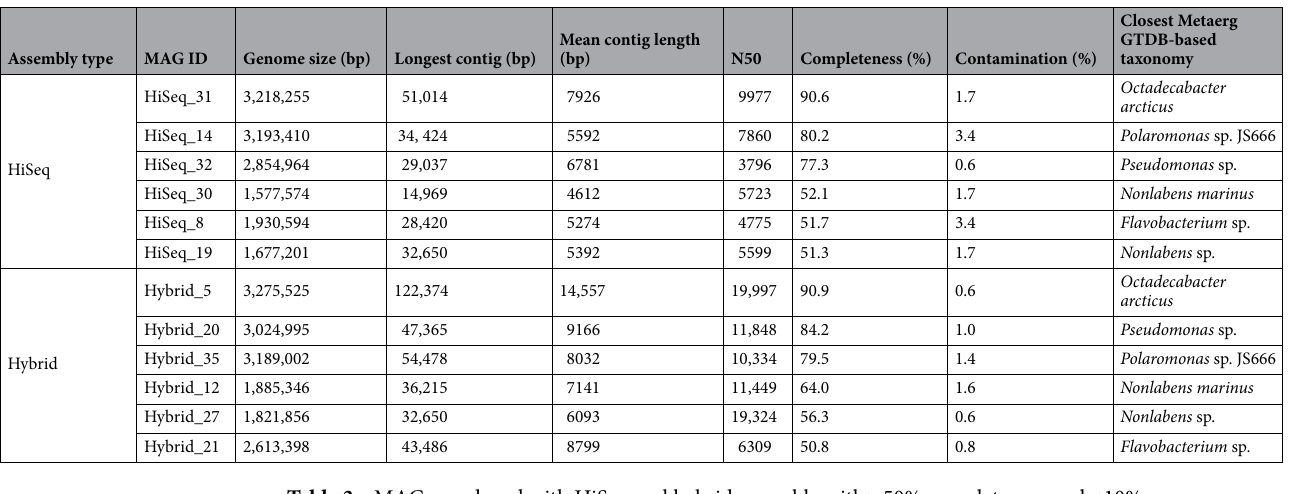
Table 3. MAGs produced with HiSeq and hybrid assembly with > 50% completeness and < 10% contamination. MAG parameters were determined with CheckM. Metaerg taxonomy is determined via predicted ORFs that inherited their taxonomy from GTDB. Taxonomy is determined to the species level if coding sequences align to one species > 50%.